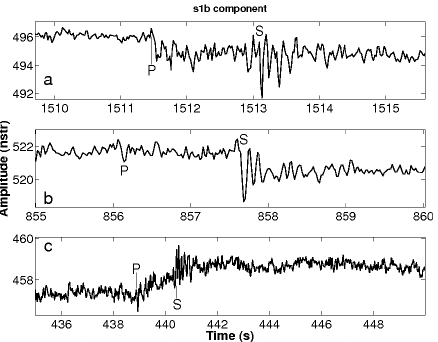
Figure 15. (a) Hourly seismicity during the year 2011 from the CRL- NET catalog. The red lines are indicating the 3 events with magnitude greater than 4 close to MOK. (b) Hourly seismicity during three days on february 2011 (4-7, days 35-38). The seismicity rate is dominated by a seismic swarm located about 8 km East of MOK (figure 1). than 0.5 s, so well before the S arrival about 1.5 s later. The second type (around 30% of the events) is a step coinciding with the (cid:246)rst S wave arrival. The last type, much less frequent, shows a ramp- like signal between the P and the S, stopping at the arrival of the S